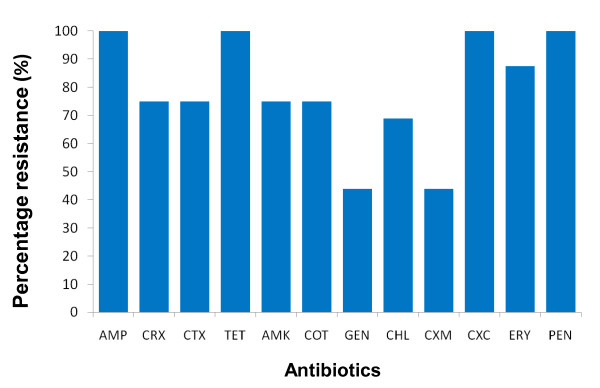
Anti bioticresistance patterns of microorganisms used.